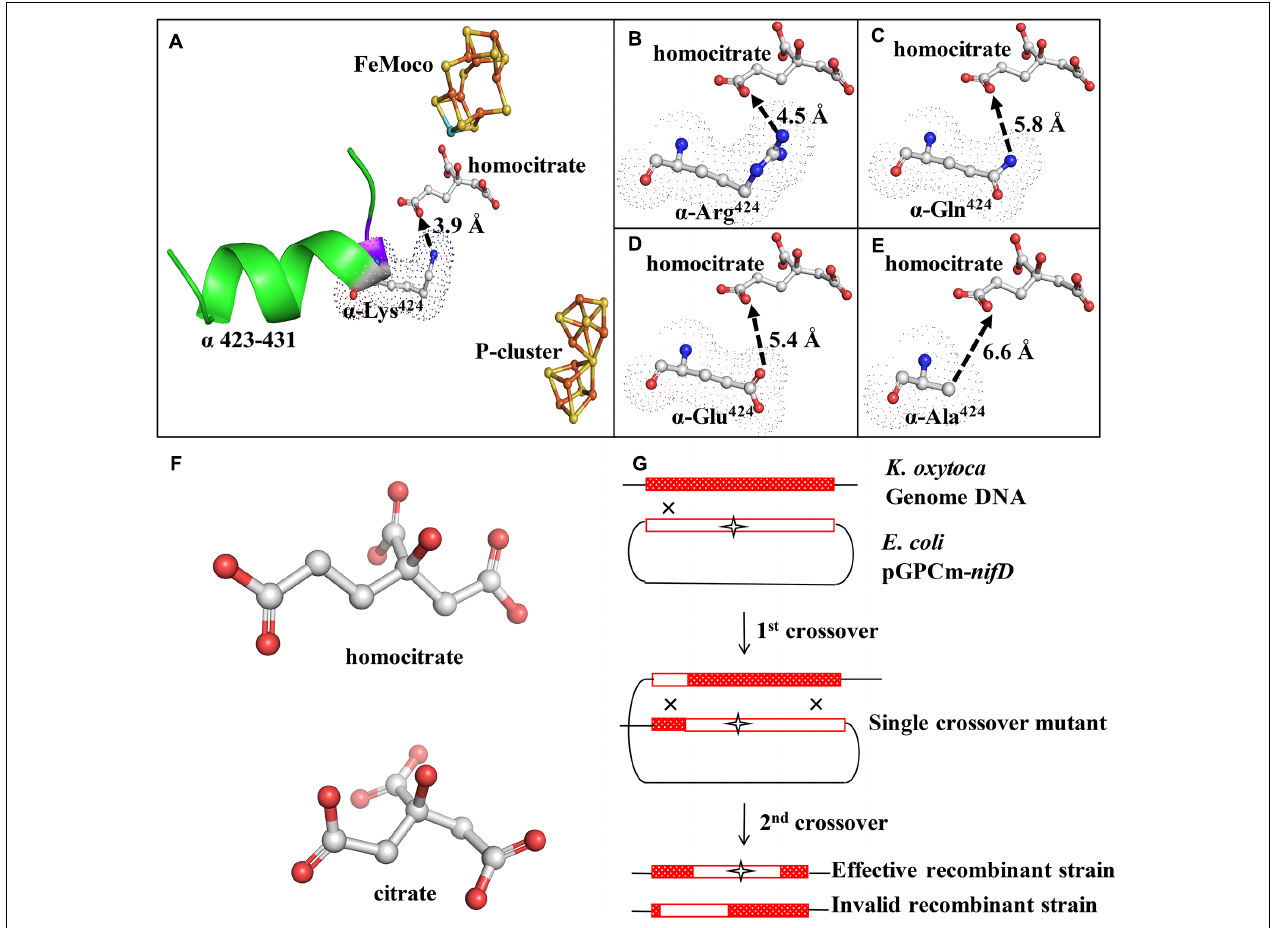
FIGURE 1 | Structure and location of α -Lys 424 and mutant construction scheme. (A) α -Lys 424 (indicated by dots) is connected directly to α -Ile 423 , and they are located in α -helix ( α 423-432) (indicated by green ribbon). Distance between N of α -Ile 423 and O4 of homocitrate is 2.8 Å. Distance between NZ of α -Lys 424 and O3 of homocitrate is 3.9 Å. (B–E) Interactions of substituted amino acids with homocitrate. Gray: C; blue: N; red: O; orange: Fe; yellow: S; cyan: Mo. Simulation and analysis performed using PyMOL software program; PDB ID: 1QGU. (F) Structure of homocitrate and citrate. (G) Construction of recombinant strains (schematic). K. oxytoca received suicide vector pGPCm from E. coli and recombined the mutational fragment to homologous sequence of its genome through two-step gene